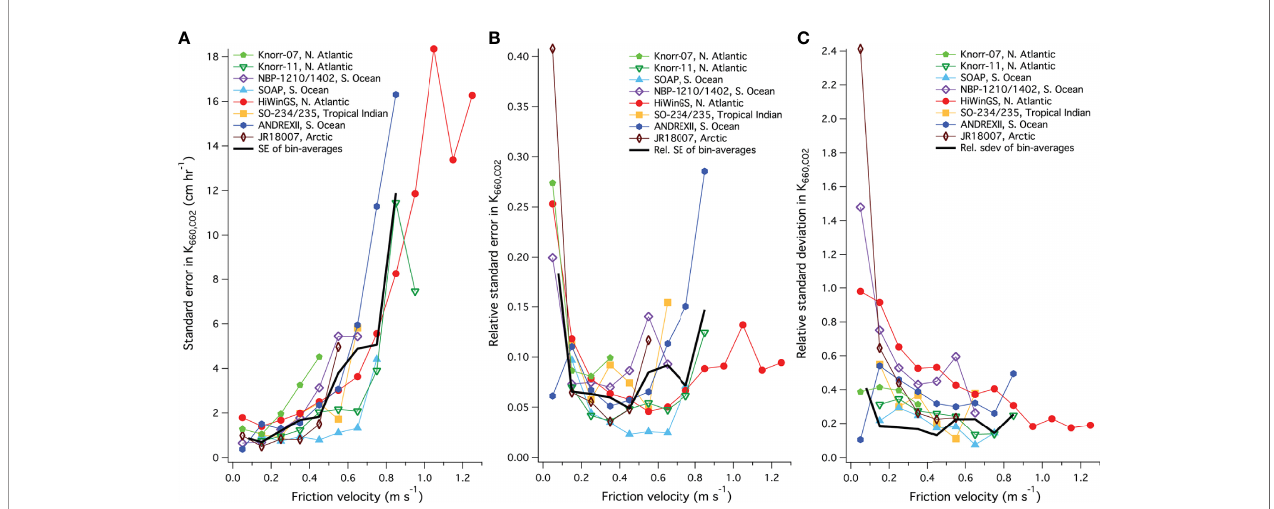
FIGURE 4 | (A) standard error in hourly K 660 for each cruise (colored markers) and the standard error of the bin-averages for all the cruises (black line); (B) the same but showing the relative standard error in hourly K 660 ; (C) the same but showing the relative standard deviation in hourly K 660 . Standard deviation here is approximately the root mean squared error, not mean absolute error.